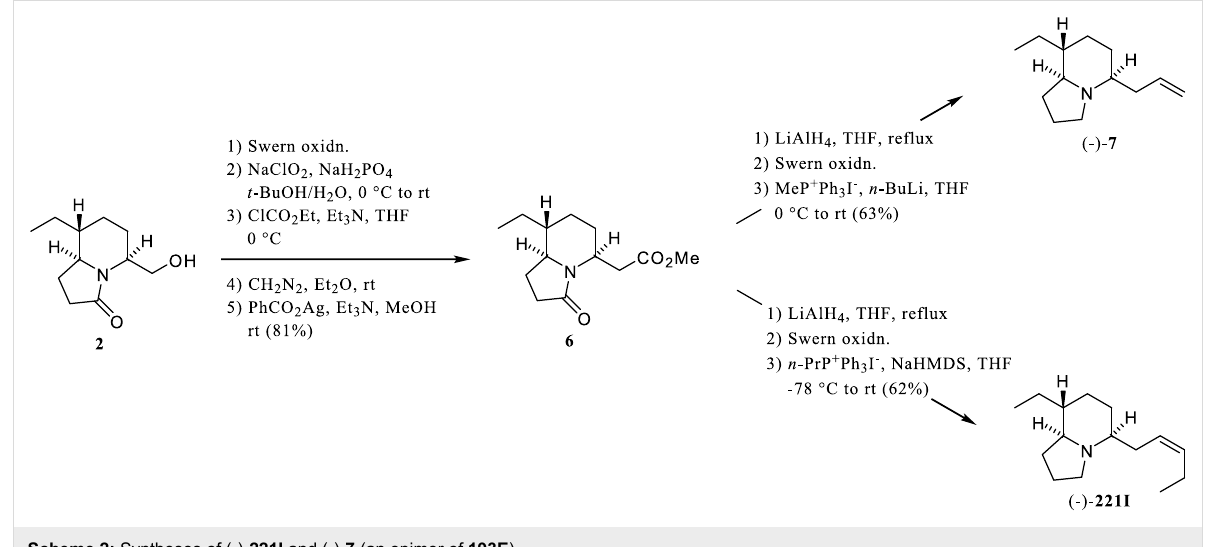
Scheme 2: Syntheses of (-)- 221I and (-)- 7 (an epimer of 193E ).